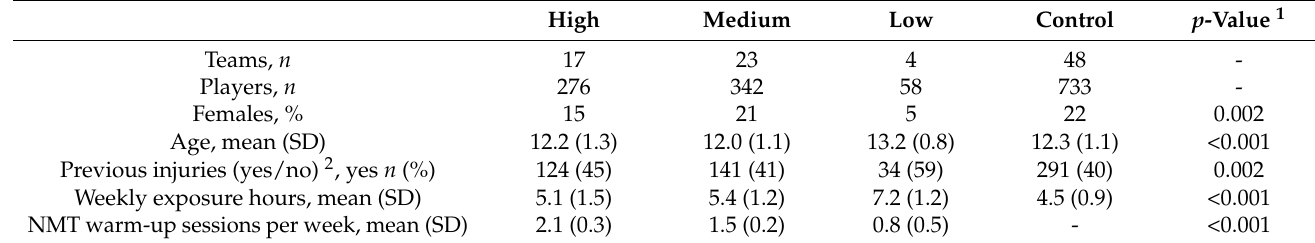
Table 1. Player characteristics by team adherence groups.